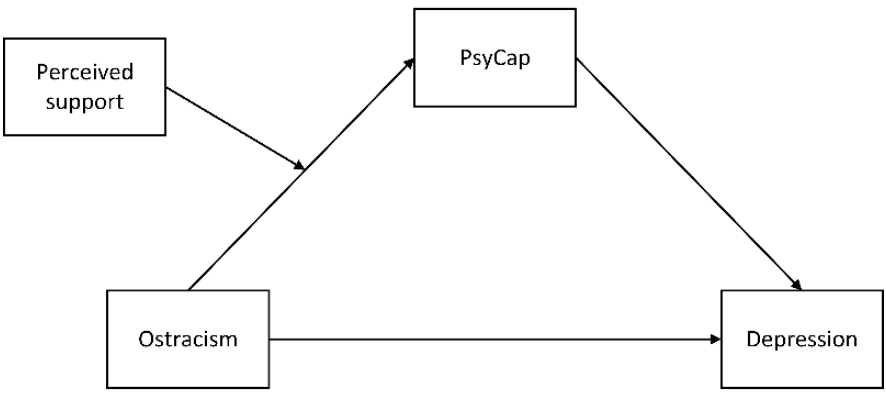
Figure 1. The proposed moderated mediation conceptual model.